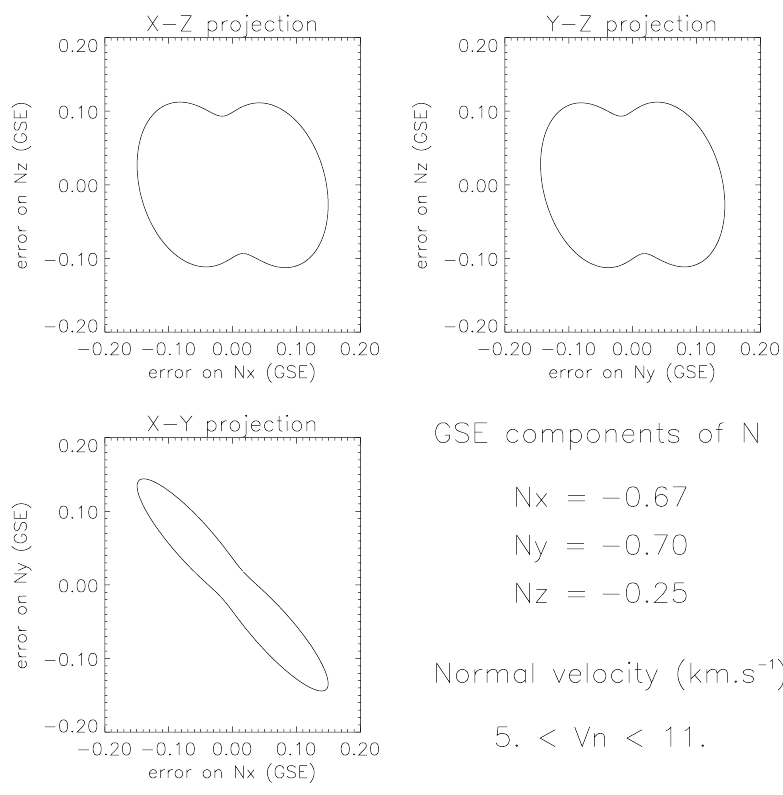
Fig. 12. GSE components of the nor- mal to the shock (first shock crossing on Fig. 9), projection of the error of deter- mination in the 3 GSE planes and the velocity of the shock along the normal. Results obtained by means of the recip- rocal vector method. The shock is going